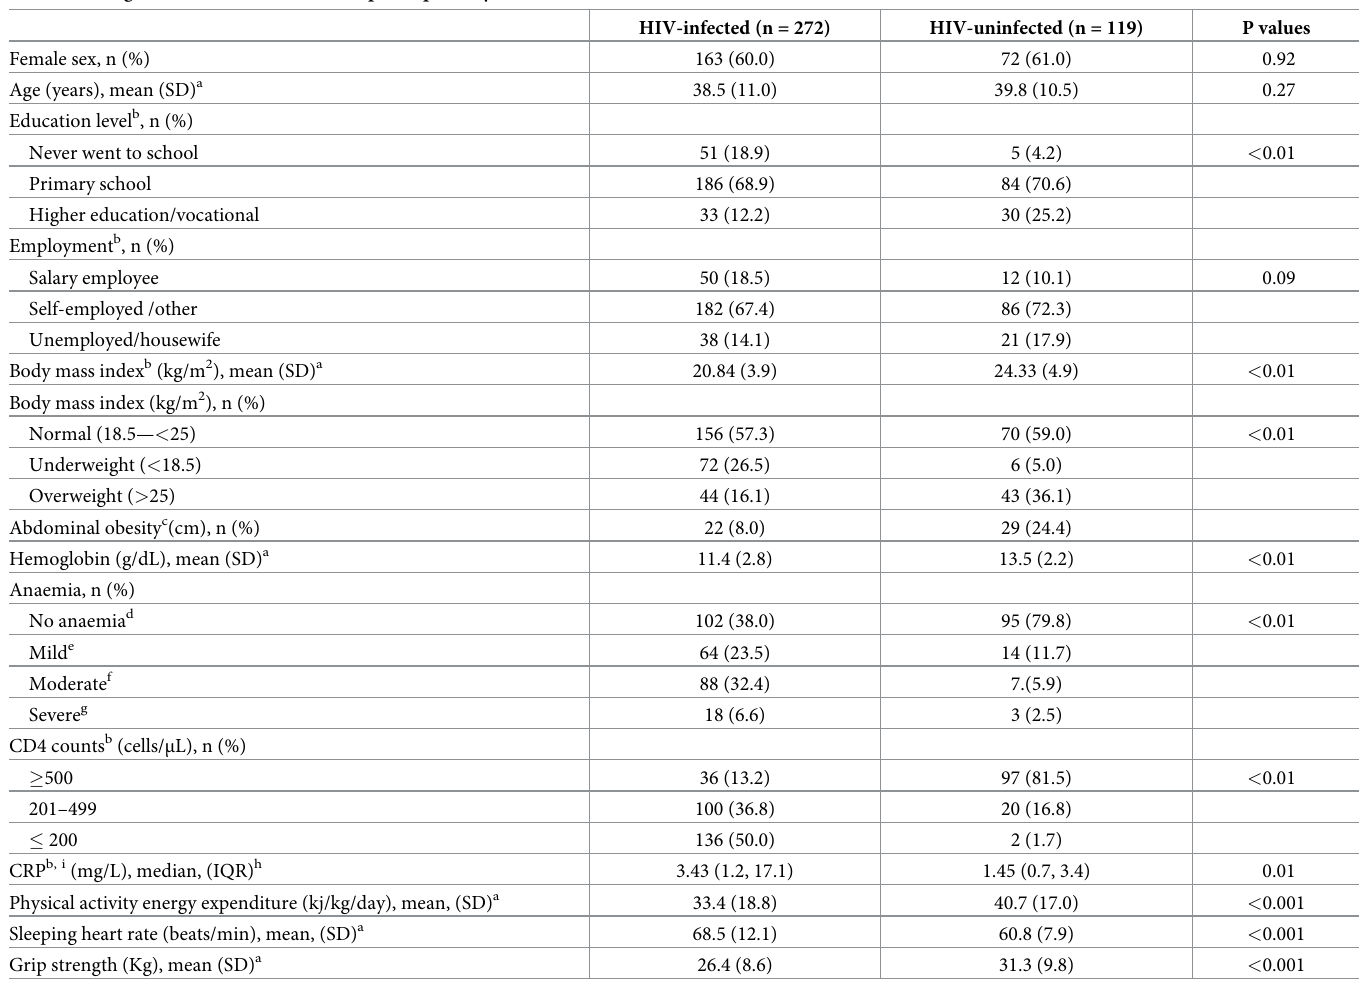
Table 1. Background characteristics of 391 participants by HIV